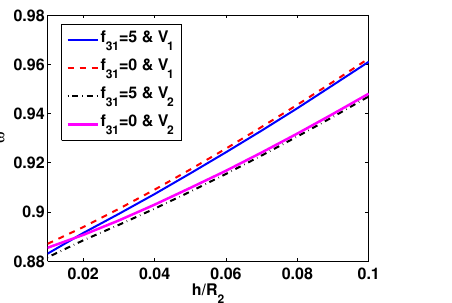
Figure 2. The effect of the flexoelectric term and volume fraction function on the frequency of FGM conical nanoshells ( α = 30, e 0 a = 1 × e − 9 , p = 1, k p = 1 × e − 3 , k w = 10 × e 12 , h p / h = 0.1, R 2 = R , ( left ) clamped-clamped boundary conditions ( right ) clamped-simply boundary